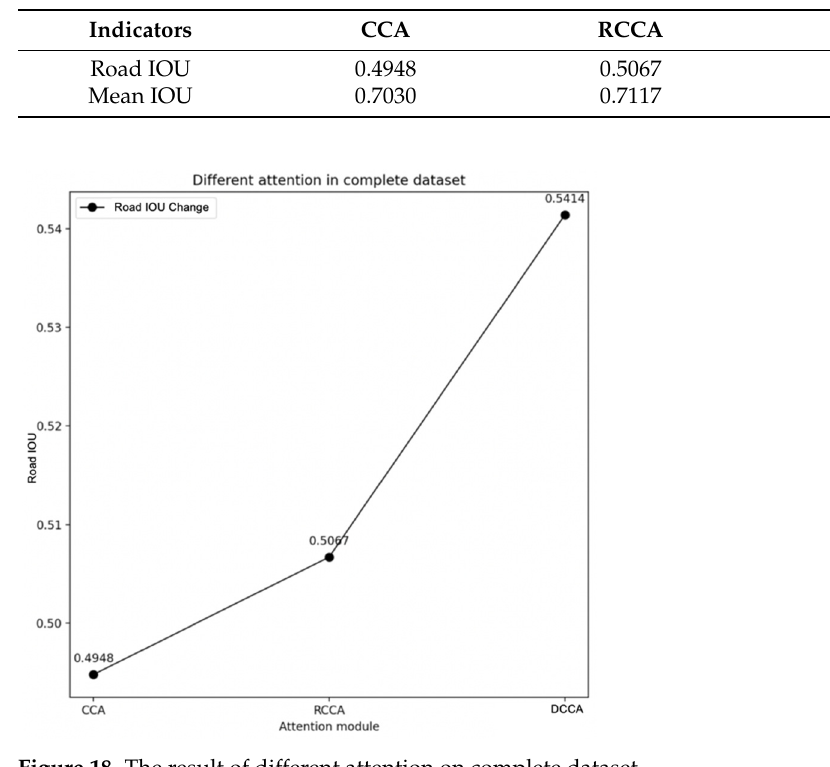
Table 5. The comparison results of other models. Models